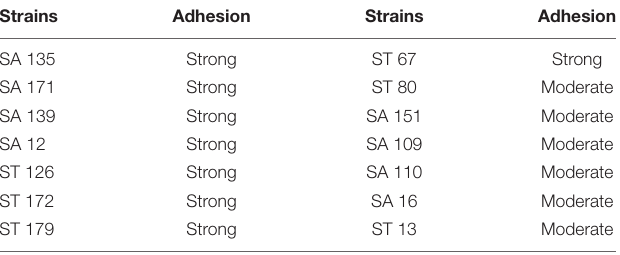
TABLE 5 | The adhesion ability of the selected isolates.